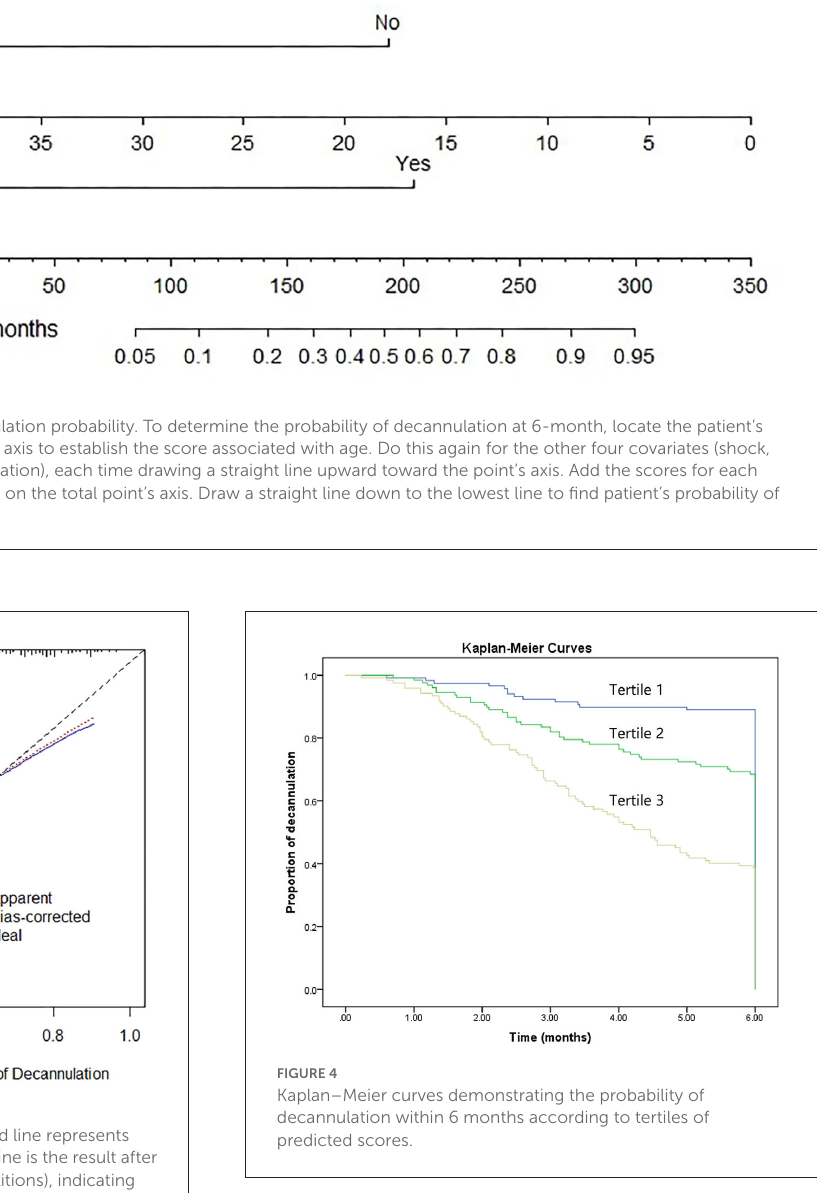
functional defects of acute stroke patients, such as difficulty in eye closure, decerebration, and decortication symptoms. For patients with stroke, GCS often overestimates degree of neurological deficit. Therefore, it may be unsuitable for stroke patients without impaired consciousness